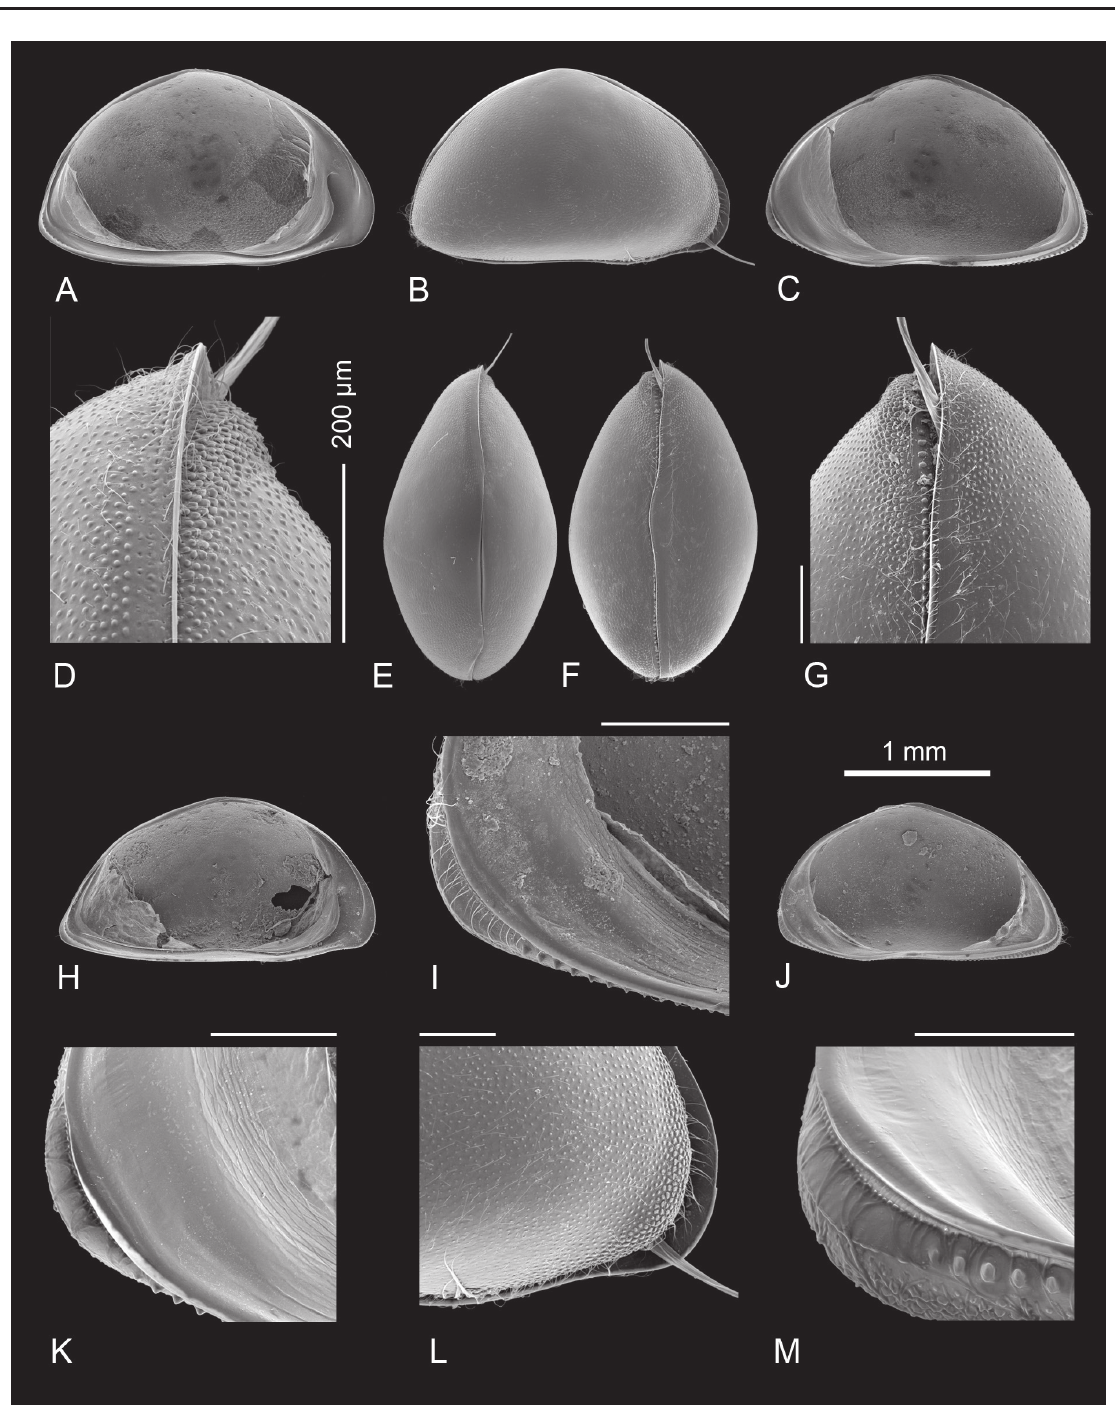
Fig. 11. Bennelongia triangulata sp. nov. (all ♀, A–G & K–M from type locality: canegrass pan